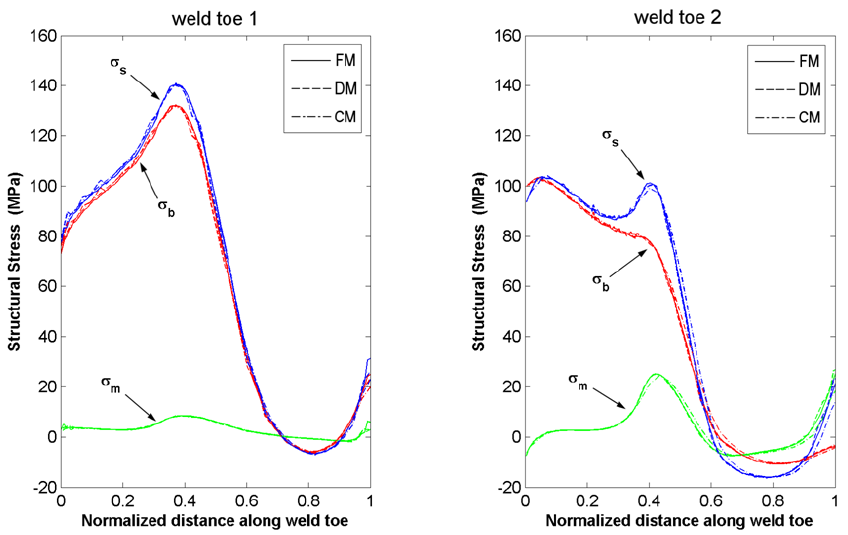
Figure 4: a) Comparison of the structural stress and its membrane and bending components along the weld toes of Fig. 3. FM: fine mesh mesh, CM: coarse mesh, DM: distorted